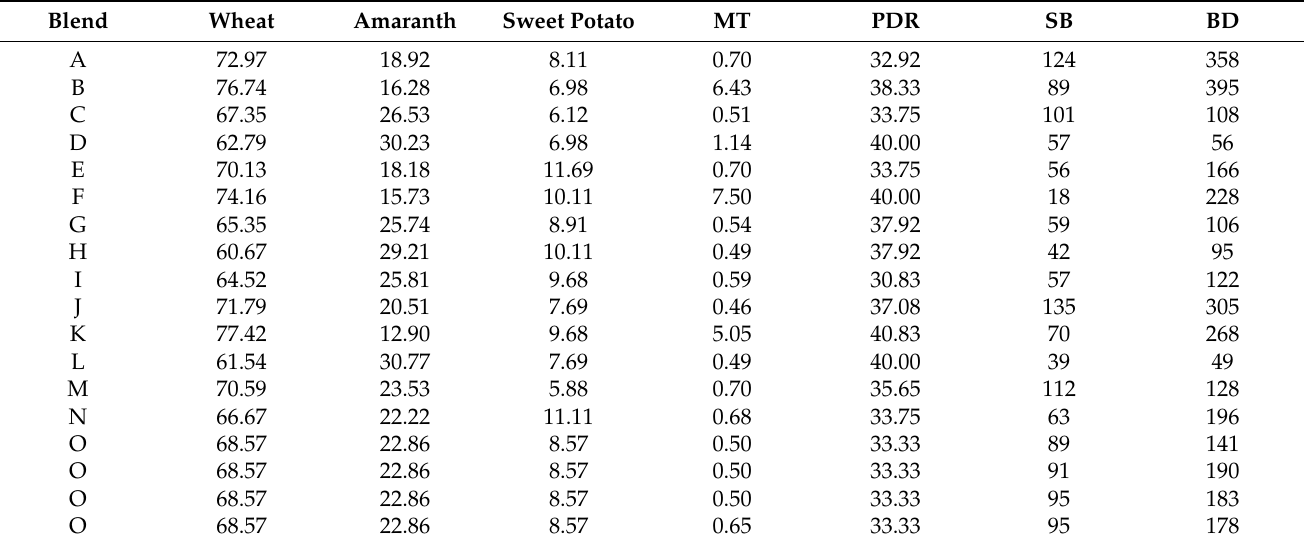
Table 1. Matrix of the central composite rotational design and experimental values of the parameters of the blends with percentages of wheat, popped amaranth and orange sweet